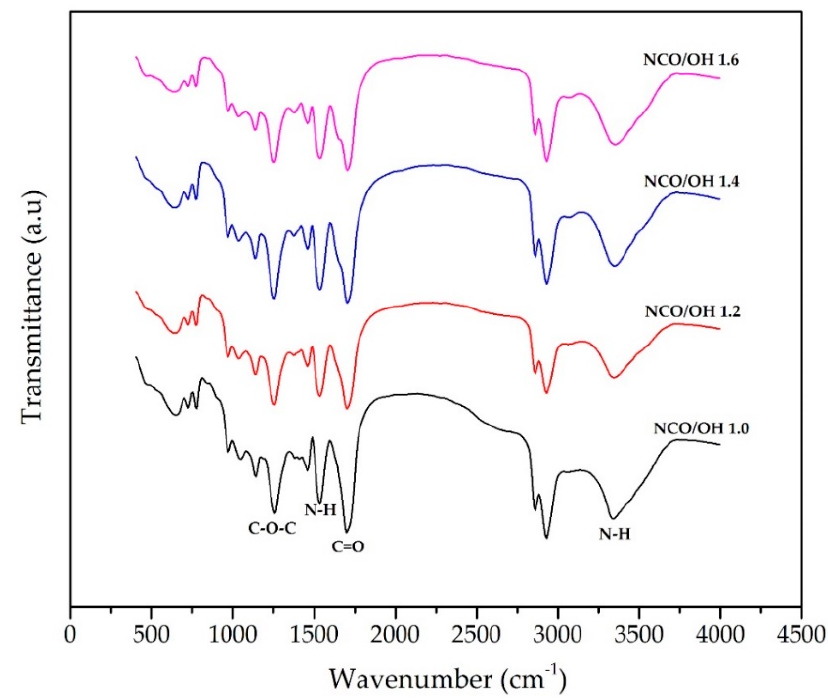
Figure 3. FTIR spectra of polyurethane-7,10-dihydroxy-8(E)-octadecenoic acid (PU-DOD) with different NCO/OH ratios.